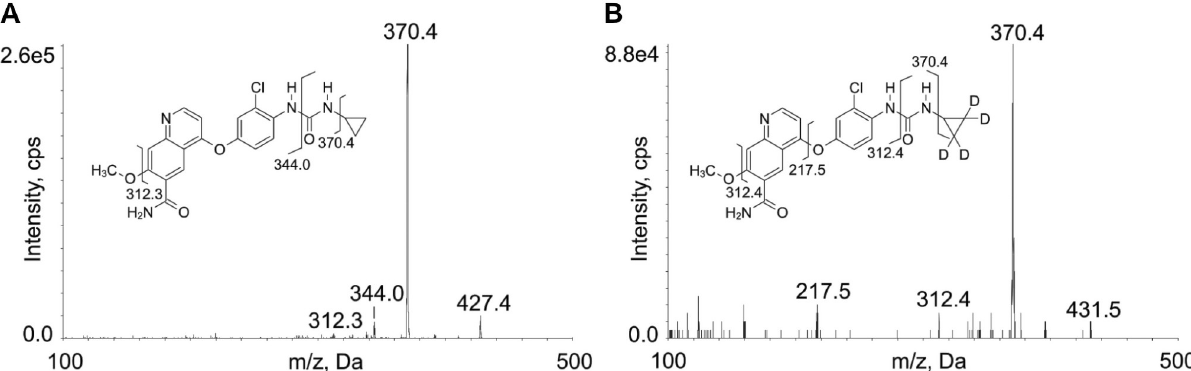
Fig 1. MS/MS mass spectra with chemical structures and identification of the fragment ions of LENVA (A) and internal standard (LENVA-D 4 ) (B); spectra were recorded with CE = 40 V. LENVA fragment at 312.3 m/z derived from 344.0 m/z fragment by the loss of methoxy group.